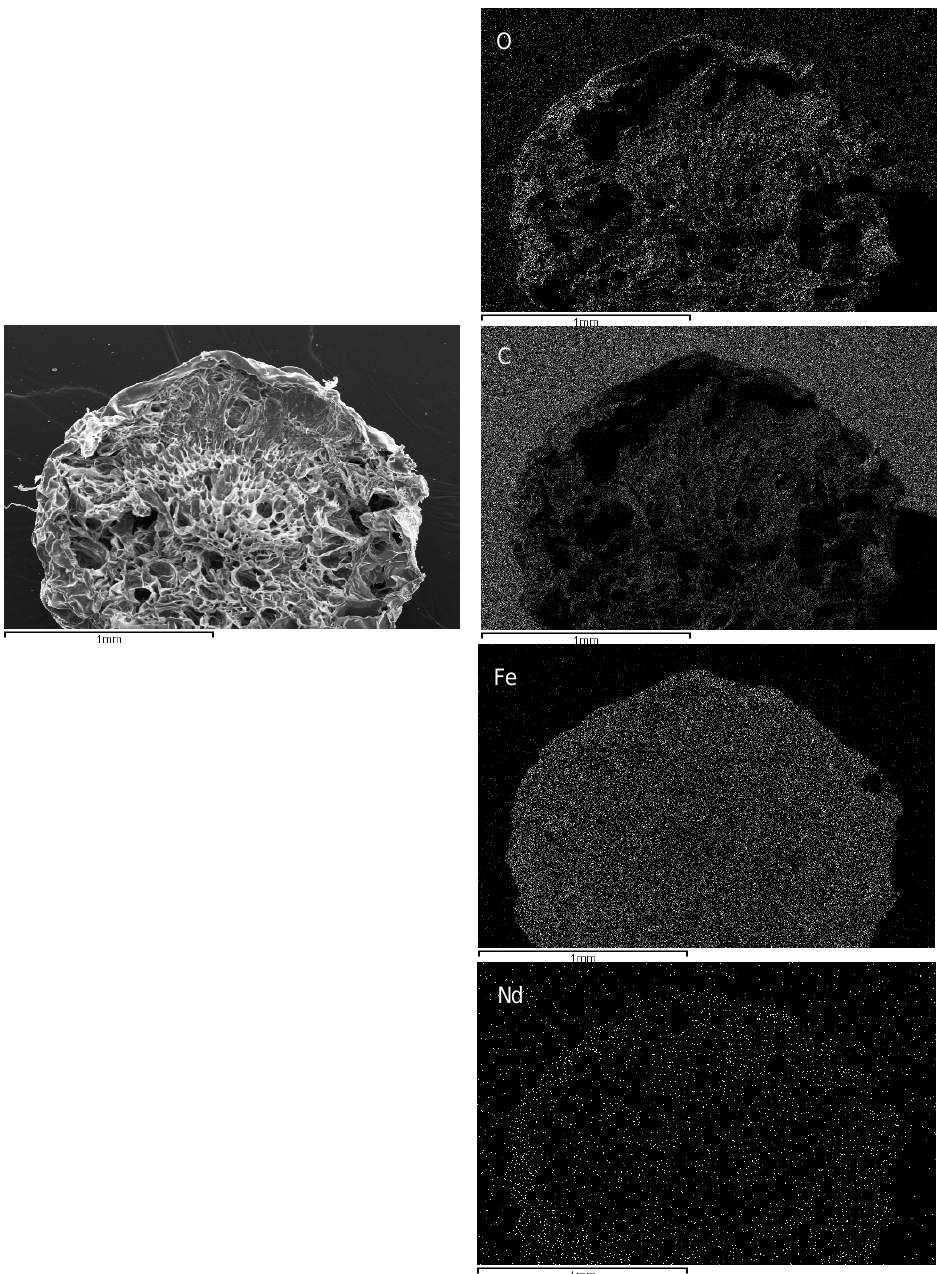
Figure 3. Distribution of the main components on the cross-section area of the ChiFer(III) material after sorption. (Right side: Original structure; left side: Distribution of O: Oxygen; C: Carbon; Fe: Iron; Nd: Neodymium).